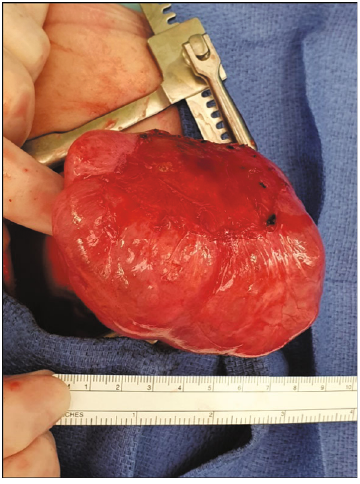
Figure 3: Intraoperative gross section of lesion.